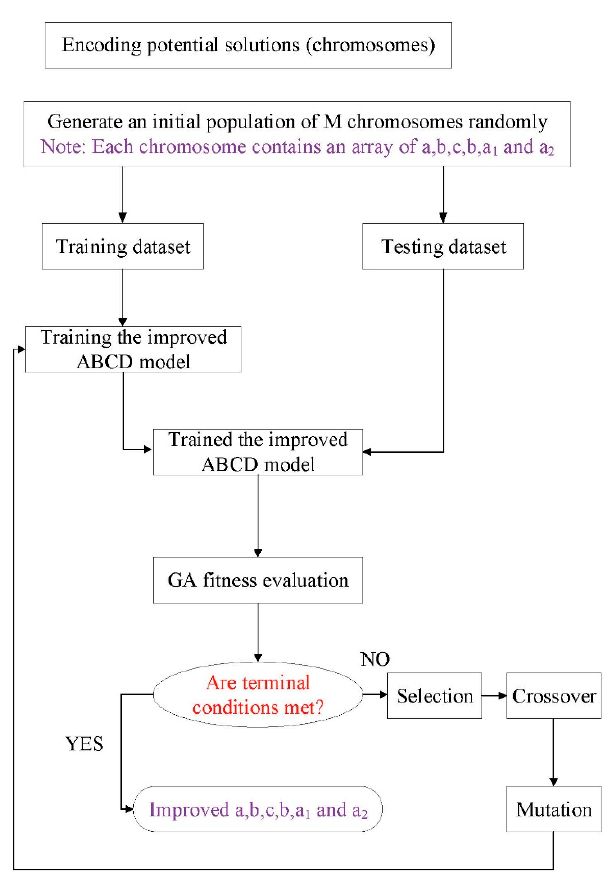
Figure 2. Flowchart of the parameter optimization base on GA.